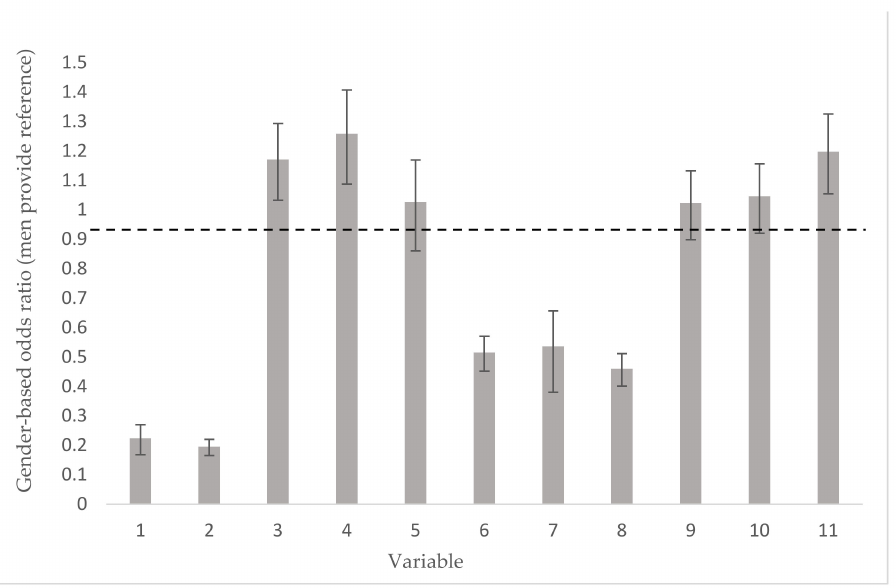
Figure 1. Odds Ratios and 95% CIs pertaining to selected indicators of awareness. Gender odds